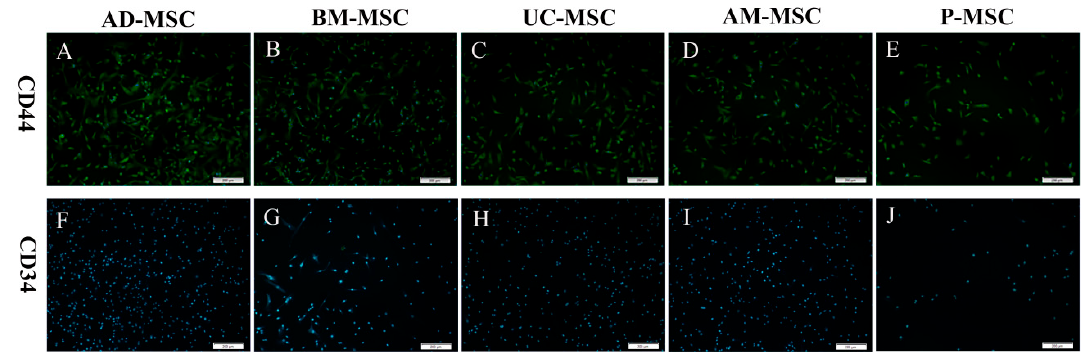
Figure 3. Immunofluorescent identification of five MSC types (100×). All five types of MSCs positively